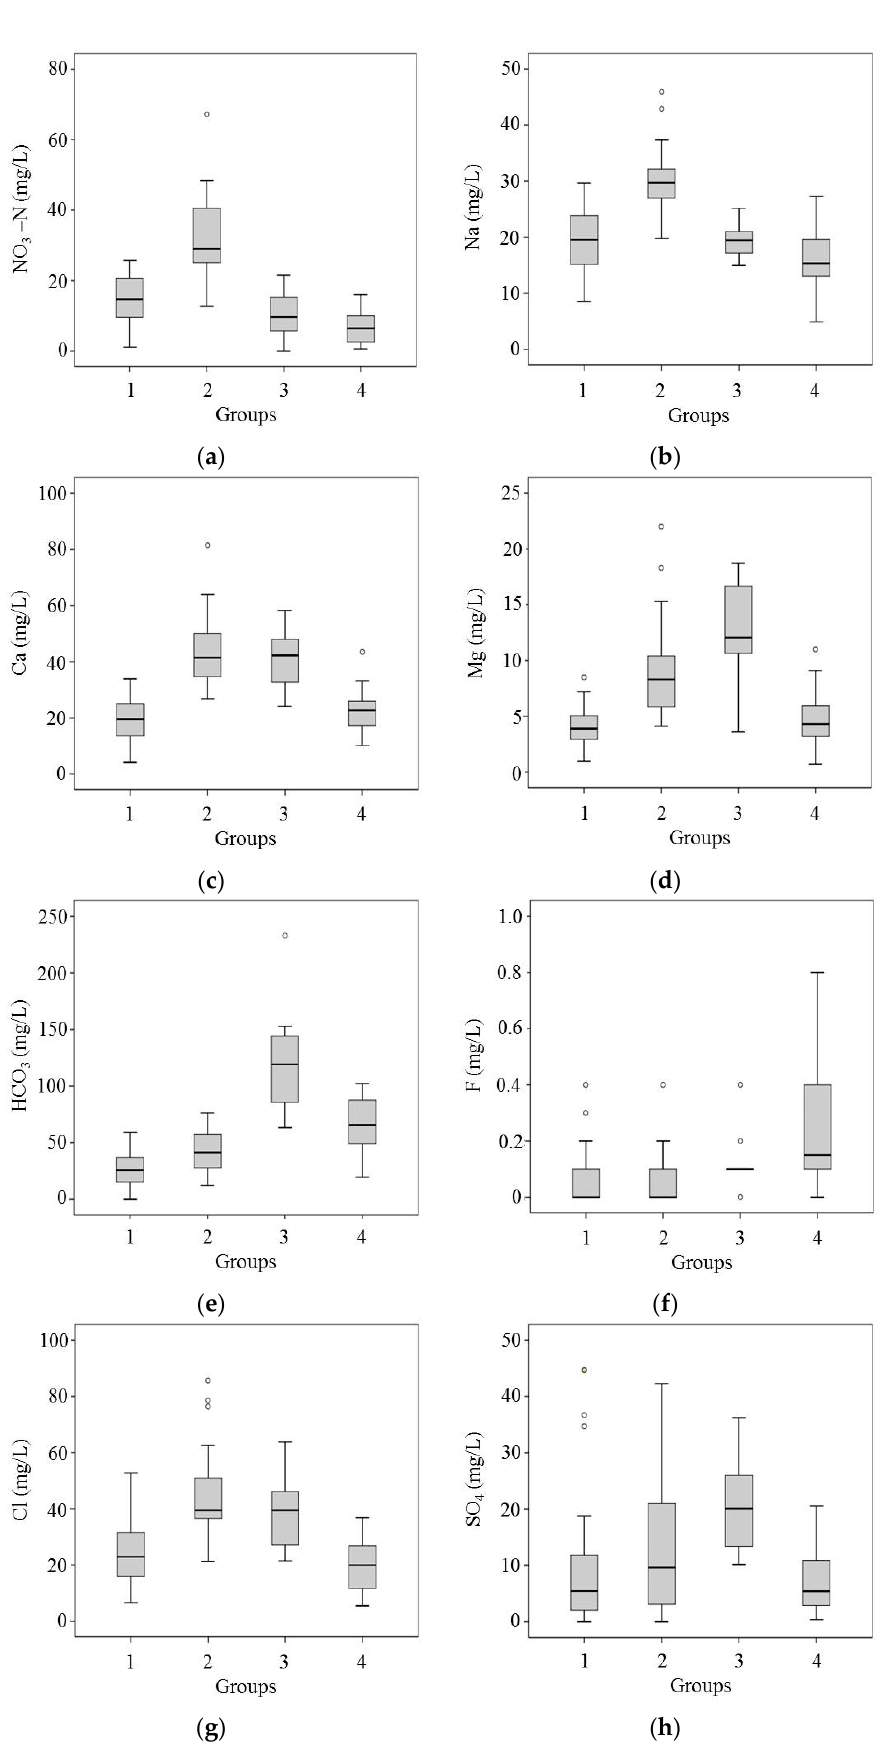
Figure 5. Box ‐ and ‐ whisker plots of some of the measured parameters of the clustered groups: ( a ) NO 3